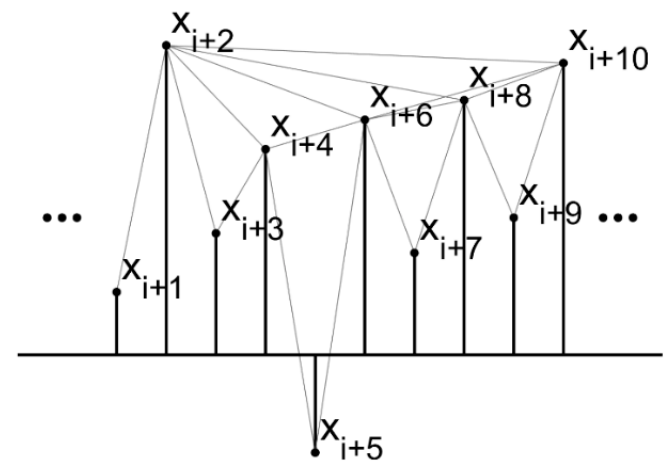
Figure 2. Illustration of converting a time series into a visibility graph.